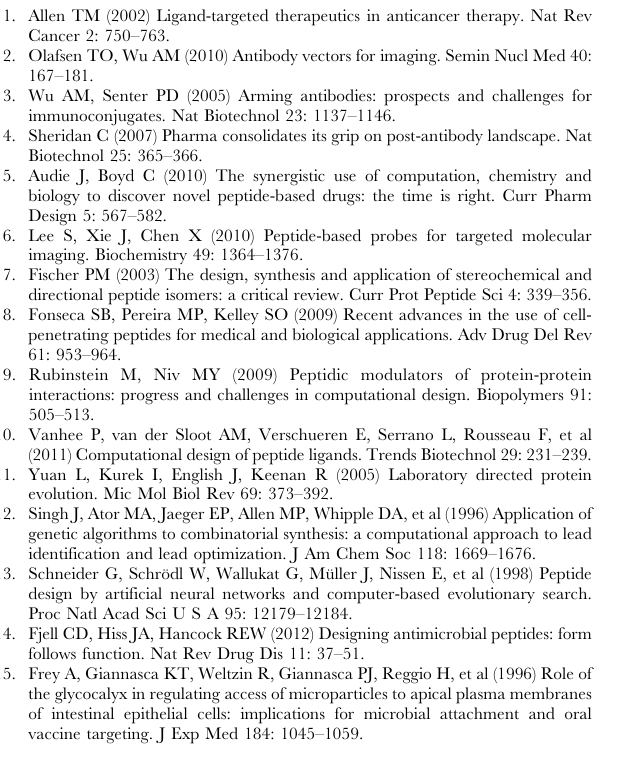
Table S1 Identification of lead sequences for the molecular evolution of G M1 -binding peptides. Table S2 List of all peptides generated in the course of the evolutionary process of optimization for G M1